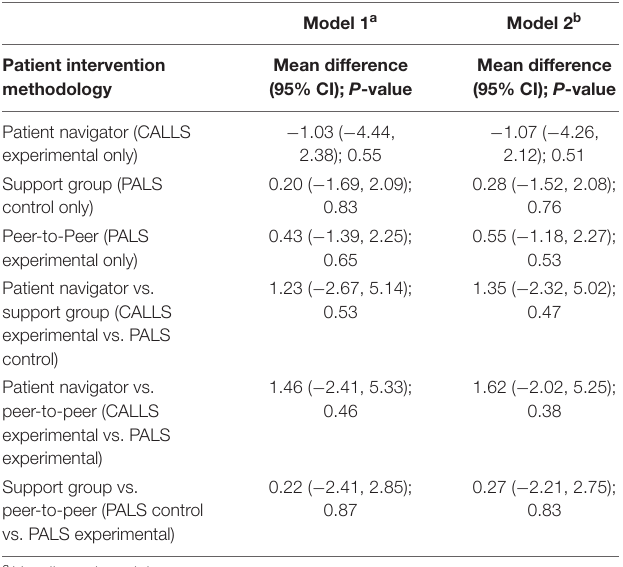
TABLE 2 | Mean differences in total patient activation measure (PAM) from baseline to post-intervention time points between patient navigator, support group, and peer to peer intervention methodologies.